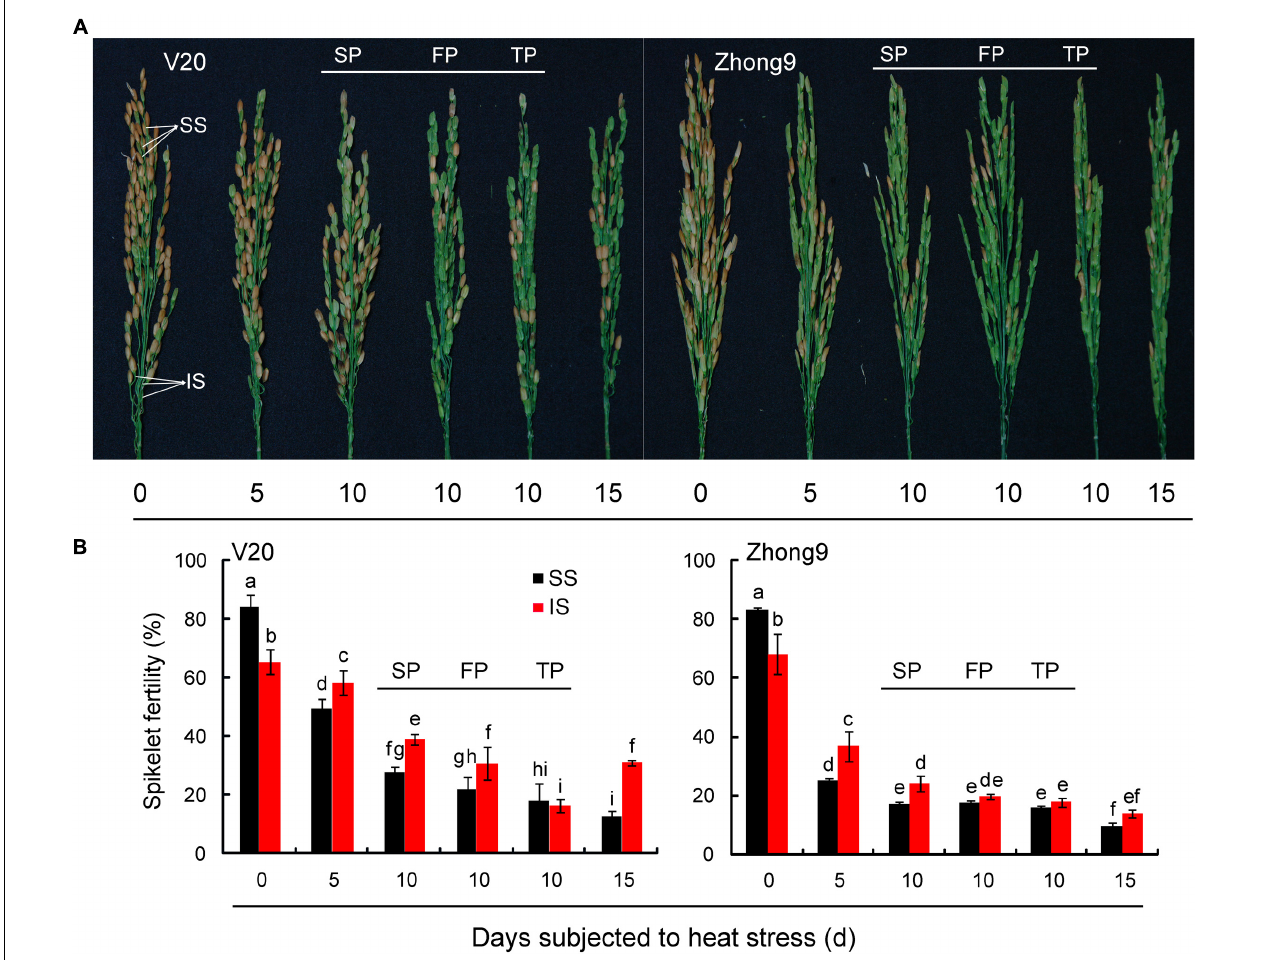
FIGURE 2 | Effect of heat stress on the spikelets fertility of superior and inferior spikelets of rice at anthesis. These rice plants were subjected to heat stress of 40 ◦ C for 5, 10, and15 days, respectively, from anthesis, and determined at maturity. (A) The pictures of panicles with superior and inferior spikelets in both genotypes under control condition and heat stress condition. (B) The mean data of fertility of superior and inferior spikelets in both genotypes under control and heat stress. SS and IS were indicated as superior spikelets and inferior spikelets, respectively. 0 day was indicated as control that rice plants without heat stress imposed. Six panicles (SP) were controlled in each rice plants except for the treatments of FP and TP. SP, FP, and TP present each rice plant possessing six panicles, four panicles, and two panicles, respectively. Vertical bars denote standard deviations ( n = 3). Different letters indicate significant differences between the superior spikelet and inferior spikelets in the same cultivar ( P <